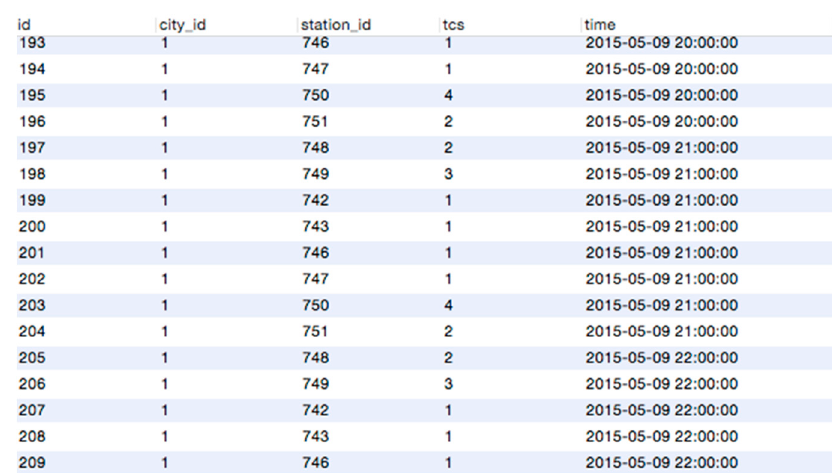
Figure 8. Traffic congestion status.